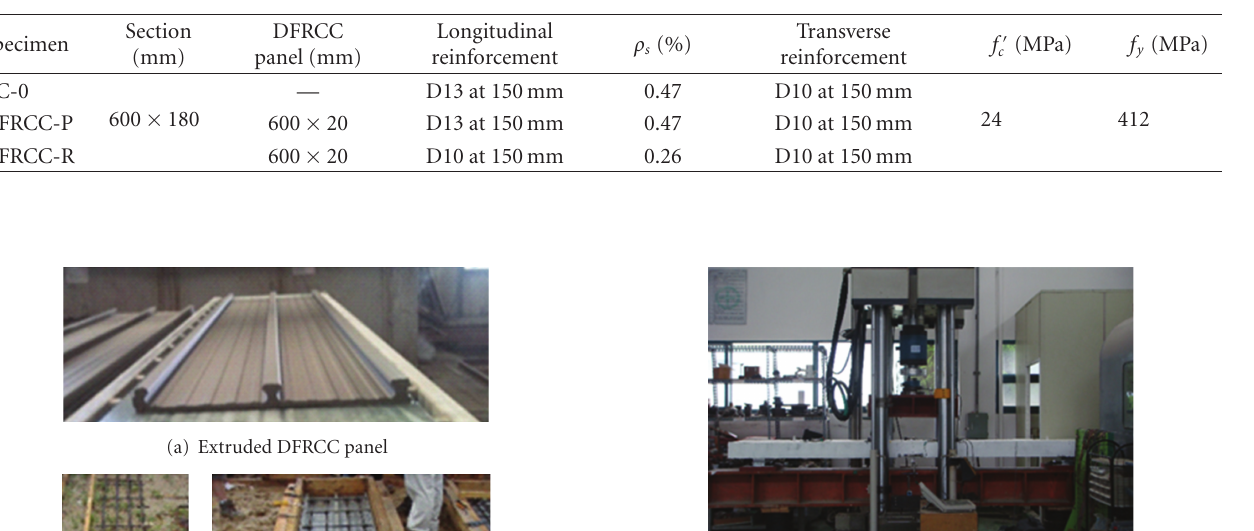
Table 5: Experimental variables of slab specimens.